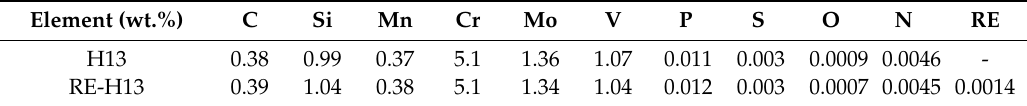
Table 1. The chemical composition of the test steels